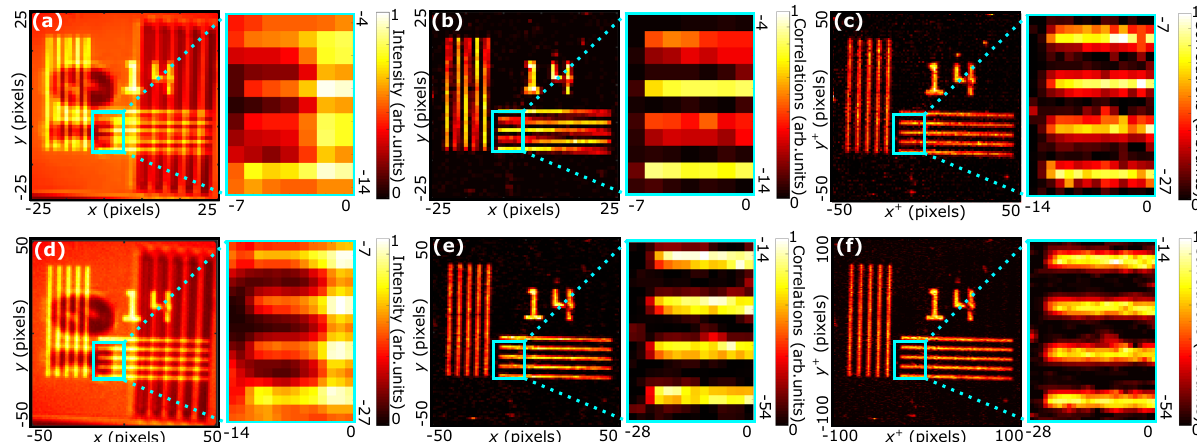
Fig. 3 Results in quantum illumination imaging. Experiment performed using a setup similar to this shown in Fig. 1a. in which another object illuminated by a classical light source (LED) is inserted. Images of both objects (positive and negative resolution charts) are superimposed onto the camera. a Intensity image, ( b ) diagonal image and ( c ) JPD pixel super-resolution image acquired using a camera with a 32 μ m-pixel-pitch. d Intensity image, ( e )